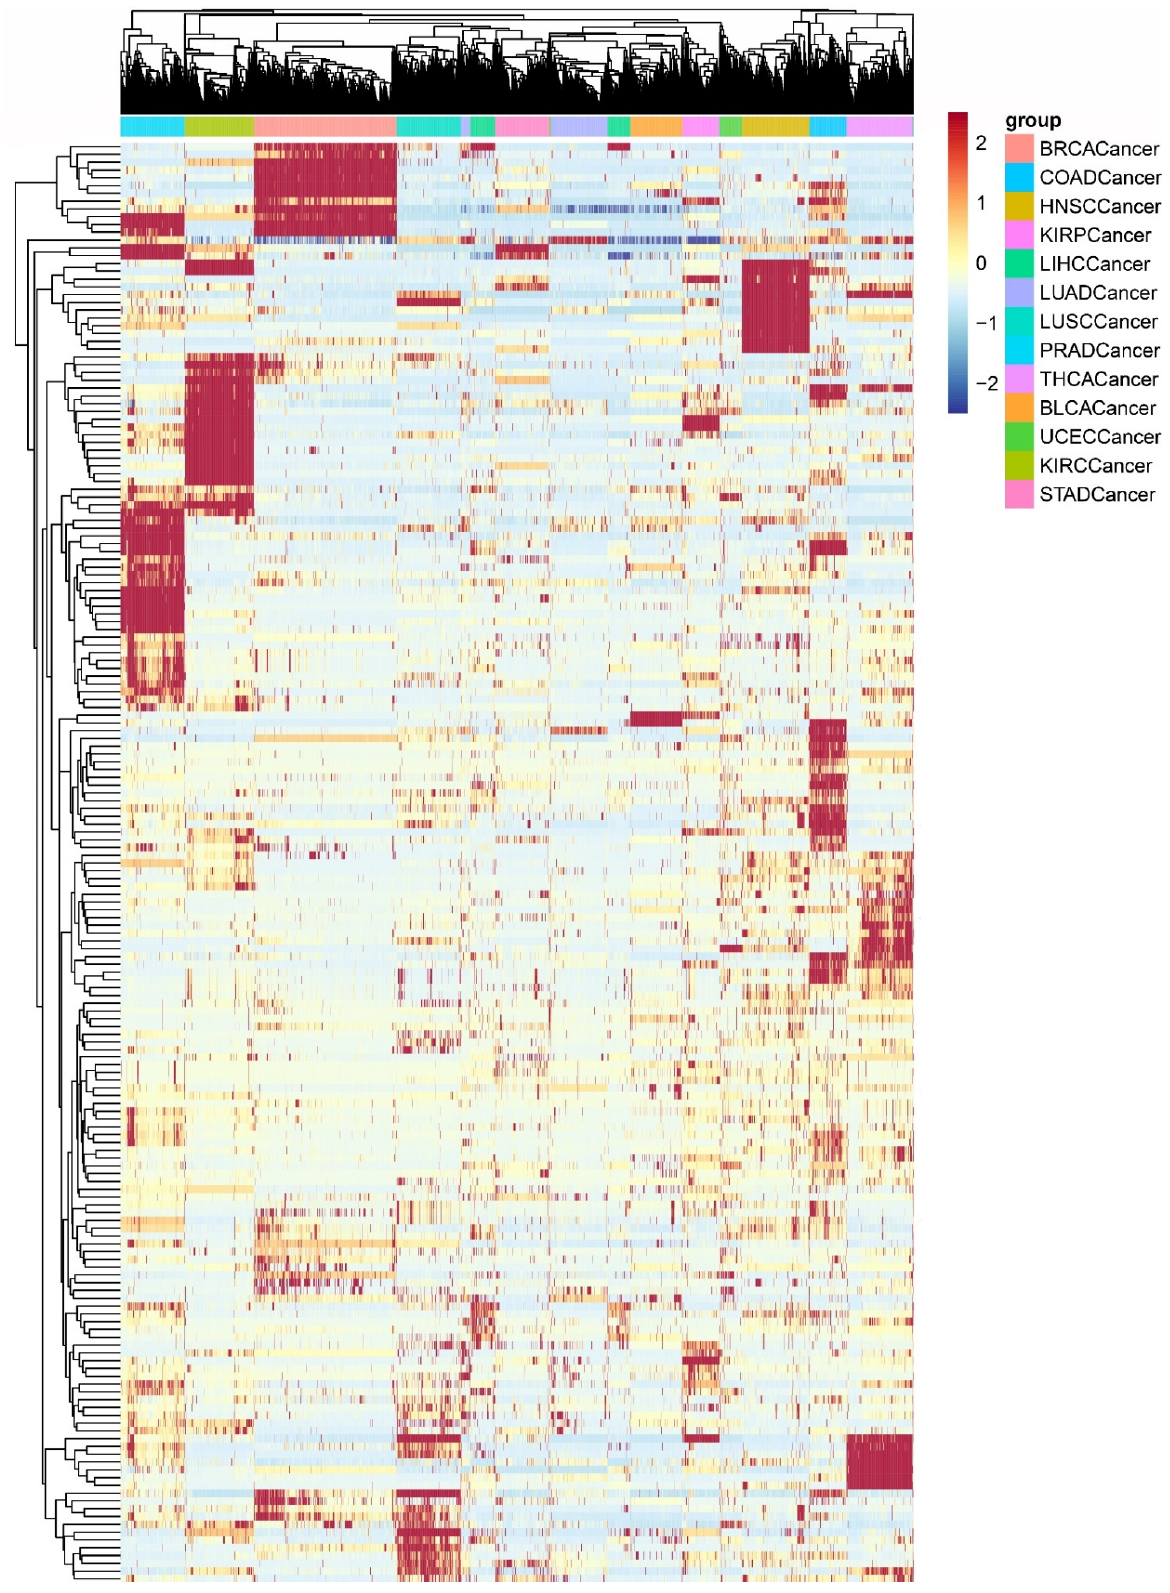
Figure 4. Clustering of PDSs for all cancer samples. The different colors of the bars represent samples of different cancer types. Each row in the matrix represents a pathway; each column represents a sample.